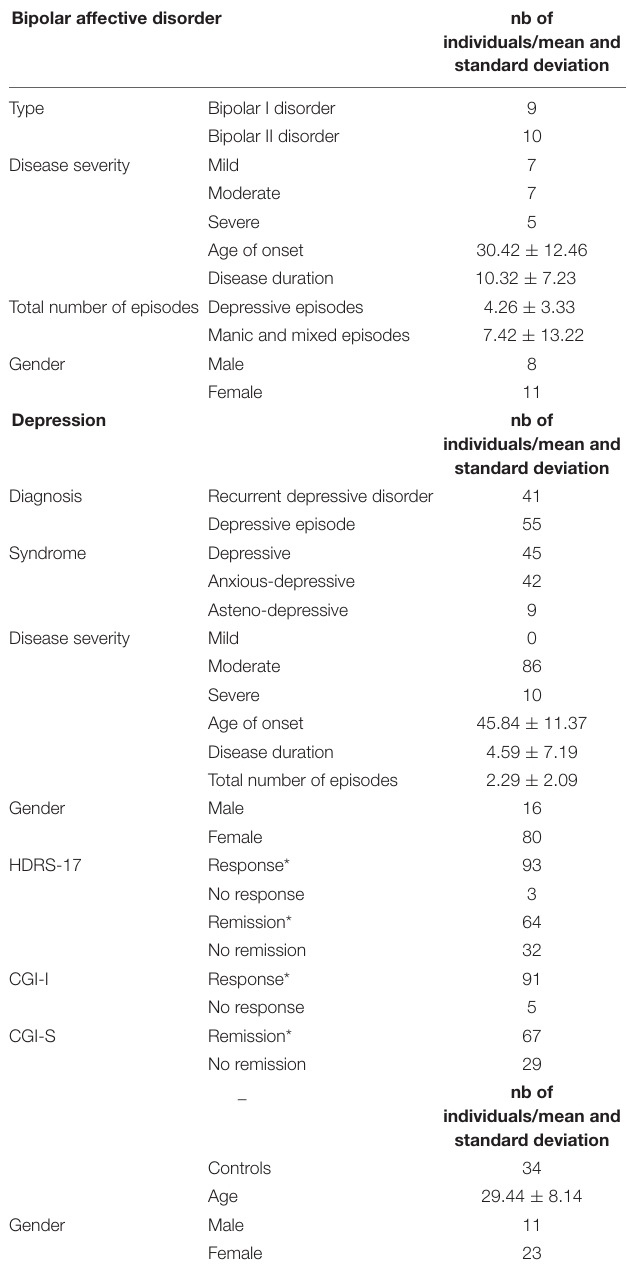
TABLE 2 | Summary of clinical features of the